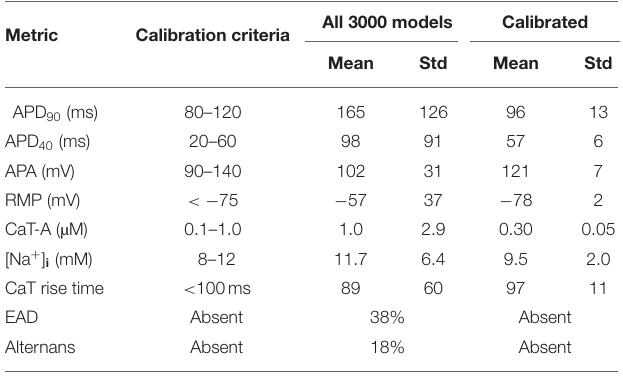
TABLE 3 | Values of electrophysiological parameters used for selecting models in the control population. Metric